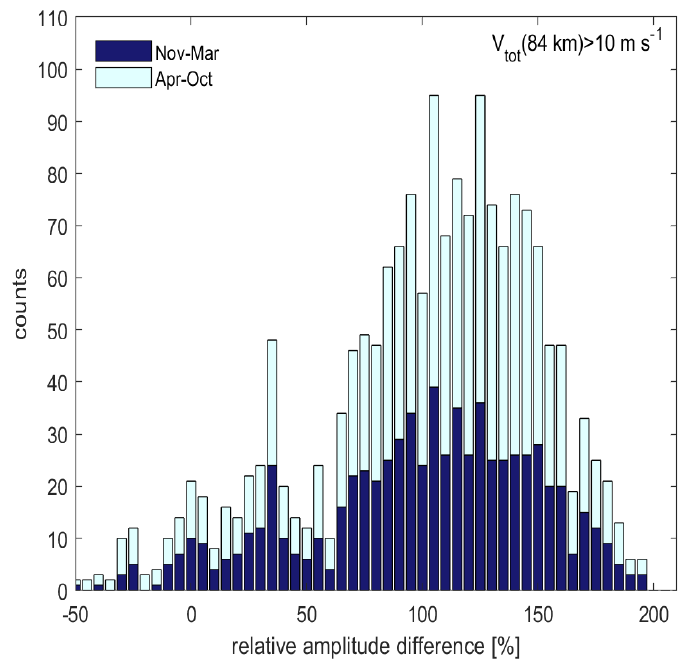
Figure 6. Histogram of the relative amplitude differences ( ∆ v) between the zonal and meridional components of the Q16DW amplitudes at 84 km. Only waves with amplitudes in excess of 10 m s − 1 are considered. There are 738 days considered for winter (indicated by the dark blue bars, November–March), whereas 285 days are considered for the remainder of the year (Light cyan bars, April–October).